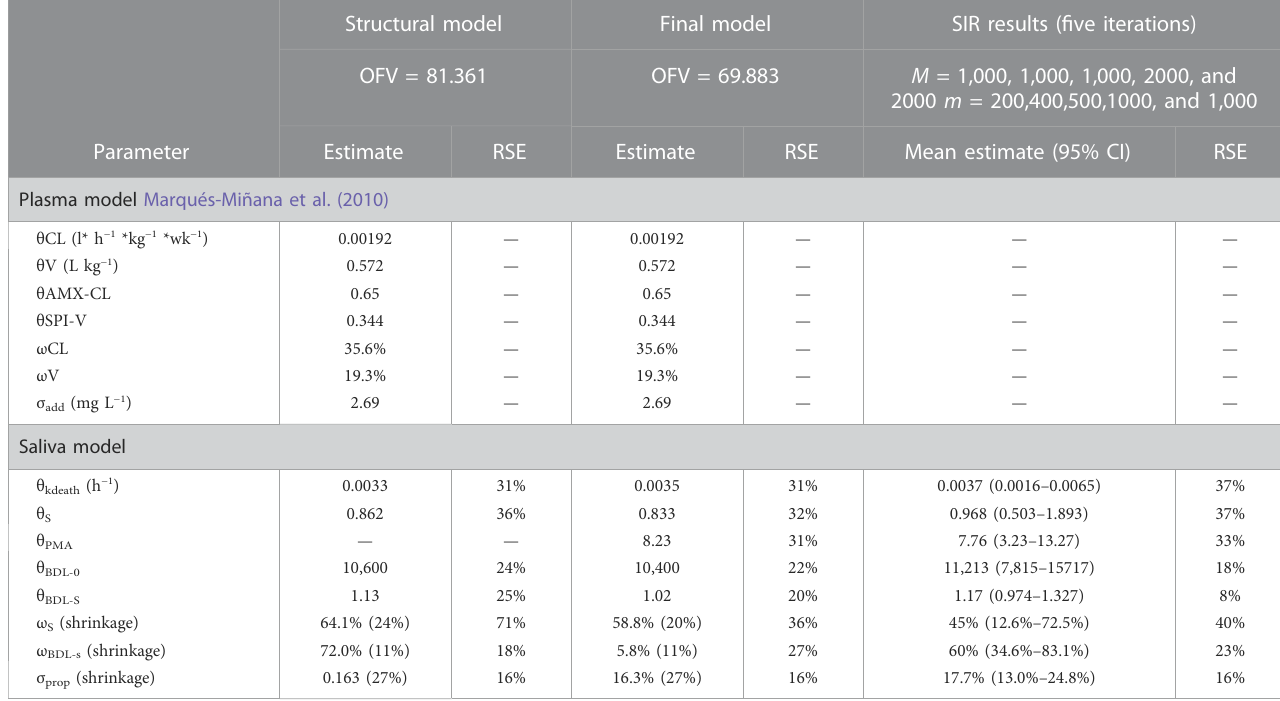
model. Relative standard errors of all parameters were within the acceptable range. GOF plots of the fi nal model indicated an adequate model fi t to the data (Figure 3). The bactericidal effect of vancomycin on individual patients is depicted in Figure 4. Model performance was evaluated using a pc-VPC ( N = 1,000) (Figure 3). The upper, median, and lower percentiles of the observations were within the 95% CIs of the corresponding simulated percentiles, indicating that the model could adequately predict the BDL levels of patients responding to treatment as a function of vancomycin PK. To assess model robustness and parameter uncertainty, SIR was performed. The SIR results of the fi nal model are shown in Table 2; Supplementary Figure S2. The proposed parameter distribution was above the reference distribution. After the fi nal iteration, the dOFV plots showed a chi-squared distribution with few degrees of freedom than the number of parameters in the model. No temporal trends were observed, and therefore the SIR results were accepted. There was full coverage of the fi nal parameters.